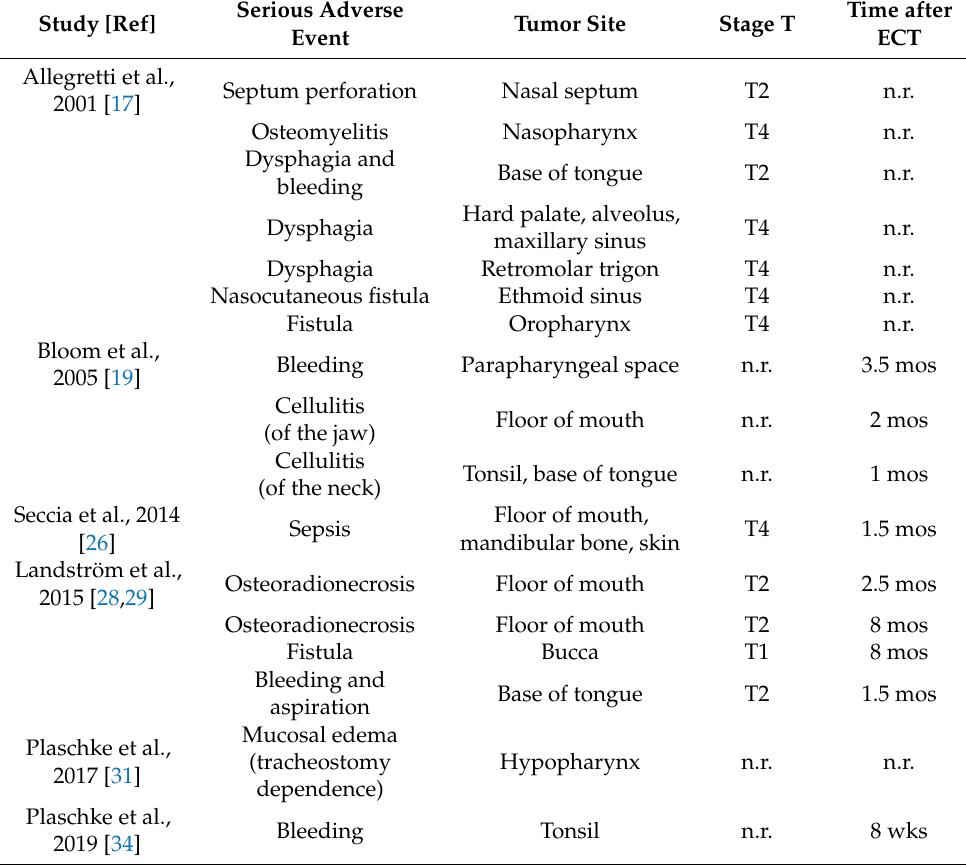
Table 5. Long-term serious adverse events after